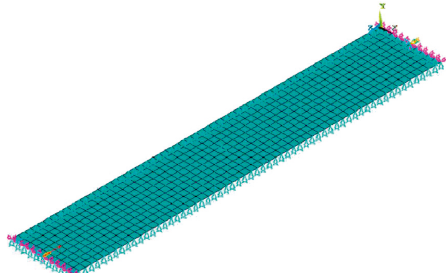
Figure 10: Applied load and boundary conditions for the internal plate. Table 4: Parameter range of the numerical investigation. Parameter